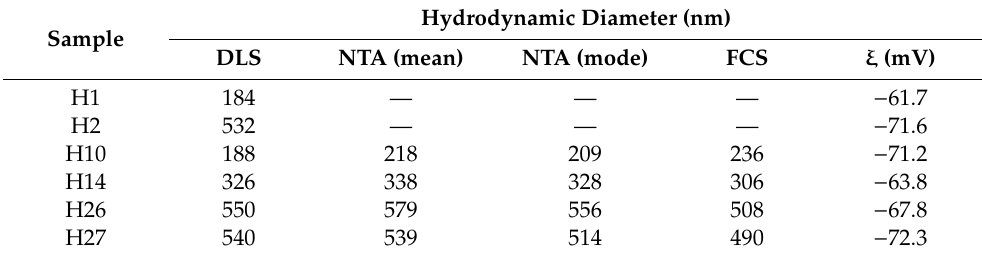
Table 3. Hydrodynamic diameters, FCS, and zeta potential ( ξ ) measured by DLS and NTA (fluorescence mode).